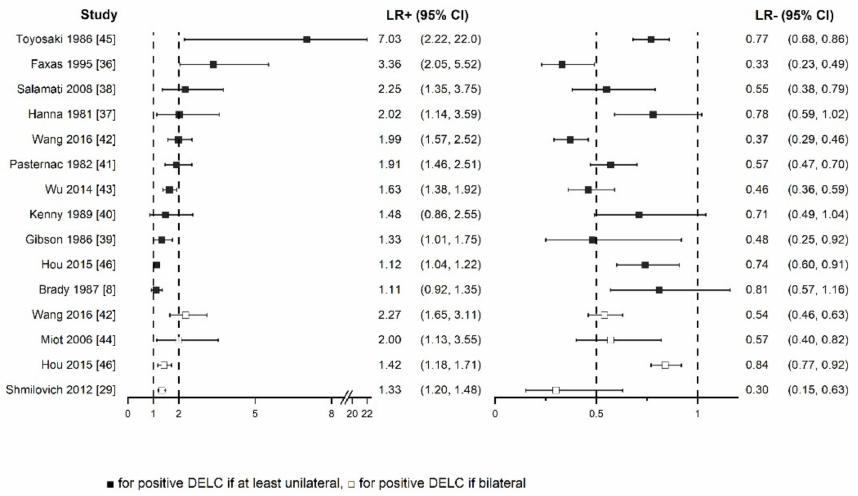
Figure 7. Forest plot of positive and negative likelihood ratios with 95% confidence